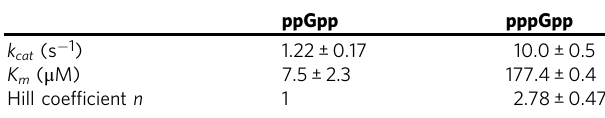
Table 1 Kinetic parameters of (p)ppGpp hydrolysis by